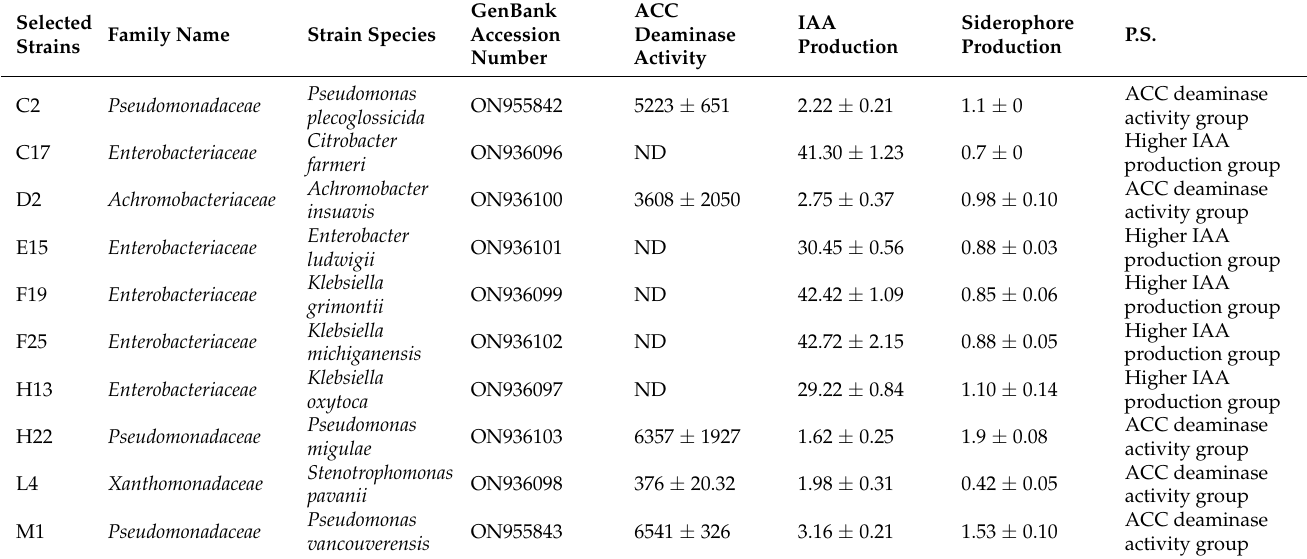
Table 1. Phylogenetic affiliation and the traits of each chosen PGPR strain, including 1- aminocyclopropane-1-carboxylate (ACC) deaminase activity (nmol ketobutyrate mg − 1 protein h − 1 ), indole-3-acetic acid (IAA) production ( µ g mL − 1 ± SD), and siderophore production (colony diameter in mm).